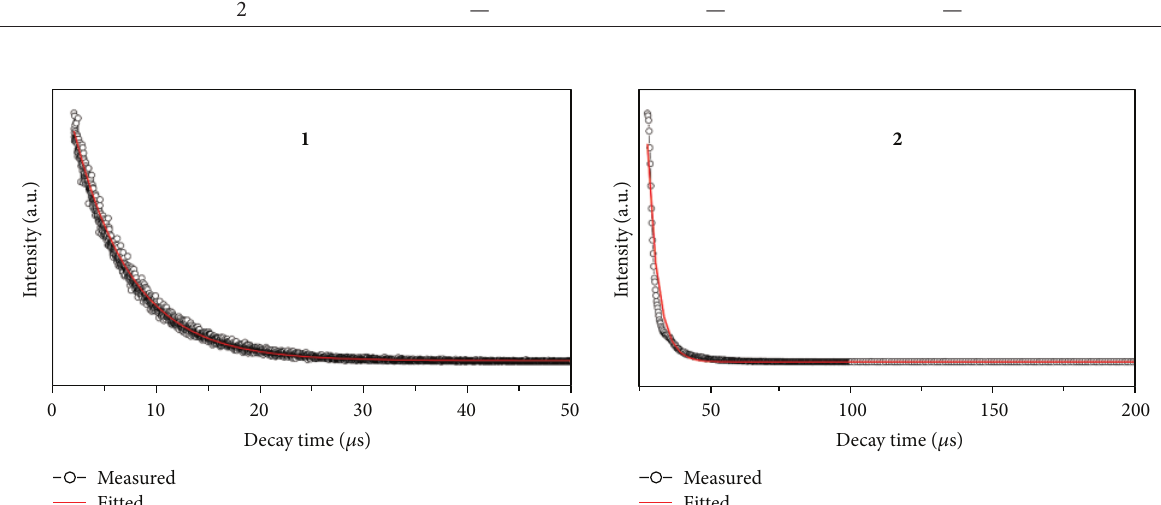
Figure 7: Luminescence lifetimes for complexes 1 - 2 in solid state at room